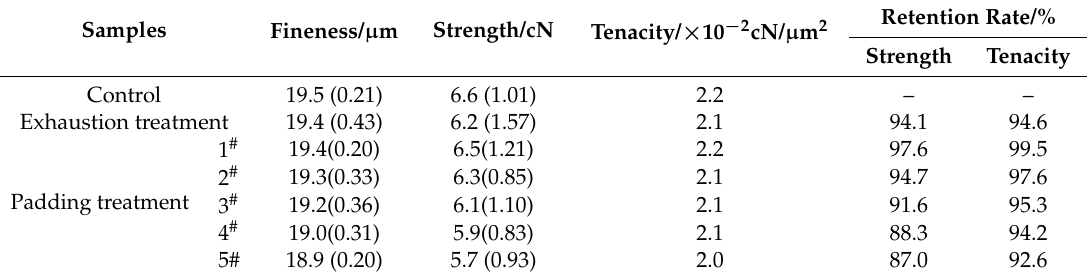
Table 2. Fiber fineness and mechanical